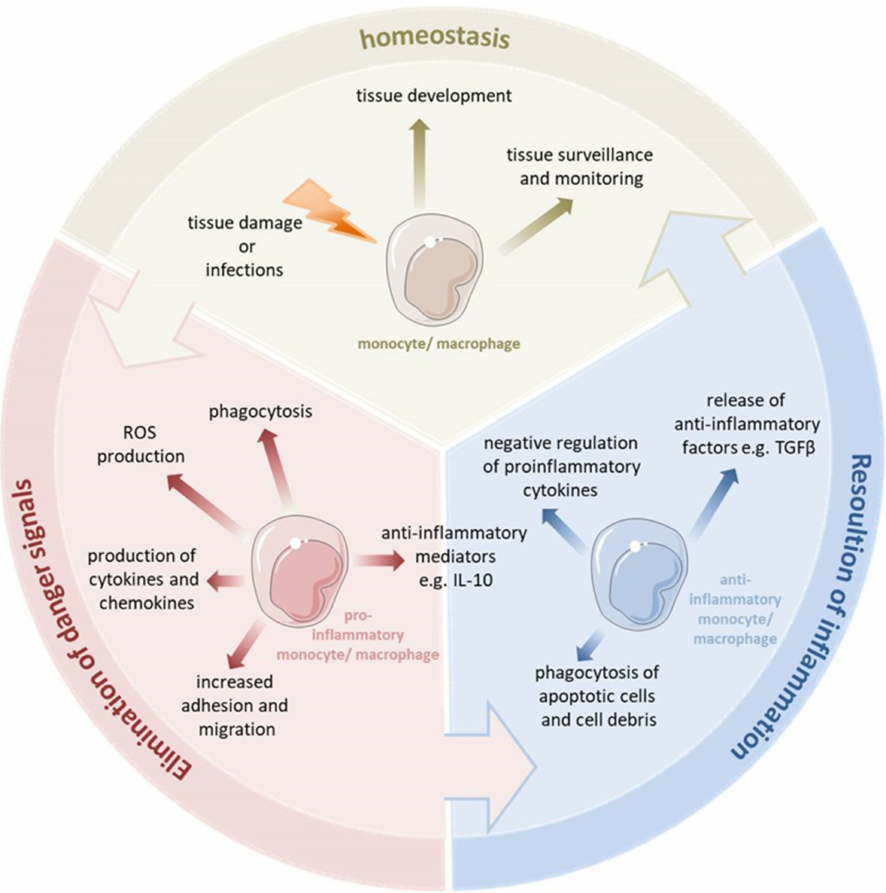
Figure 1. Monocytes and macrophages are a central component of the innate immune system. They are able to switch their phenotype from a homeostatic state to the proinflammatory state to eliminate pathogens and fight the inflammation. During uncomplicated inflammation, a switch from a proinflammatory to an anti-inflammatory phenotype occurs which enables the resolution of inflammation and the re-establishment of homeostasis. This enables the monocytes and macrophages to play diverse roles in the inflammatory response, both encouraging and discouraging this process. Depending on the kind of signal or pathophysiologic condition, monocytes and macrophages can undergo specific phenotypic polarization and thus acquire distinct functional